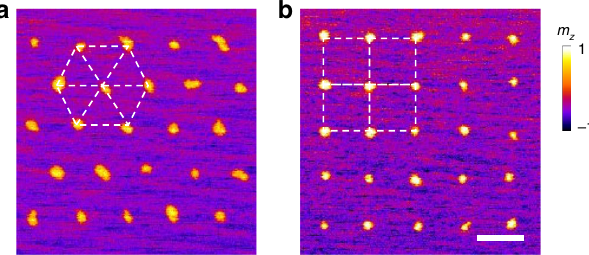
Fig. 5 Arti fi cial skyrmion lattice patterned by X-ray illumination. a Triangular skyrmion lattice. b Square skyrmion lattice. The sample used here consists of Ta (3 nm)/[Pt (1.5 nm)/Co (0.8 nm)/IrMn (5 nm)] 12 /Ta (2 nm). The sample has a uniform exchange bias (induced during the deposition process via an applied external fi eld) and exhibits single domain at zero fi eld. During the creation of the skyrmion lattice, a magnetic fi eld of − 200 mT (opposite to the as-grown exchange bias direction) is applied. The scale bar in b is 1 μ